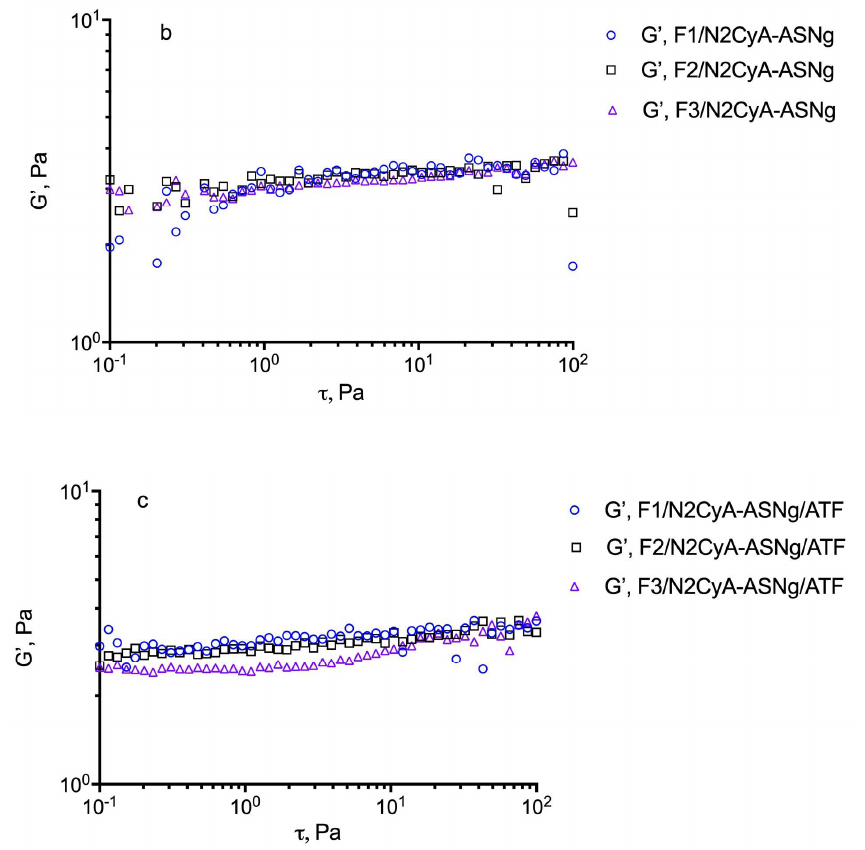
Figure 4. Determination of the linear viscoelastic range (DLVR). Elastic modulus (G’) at 5 Hz plotted versus shear stress (t) for: ( a ) GG-LA dispersions (Fx), ( b ) GG-LA dispersions containing nanomicelles (Fx/N2CyA-ASNg) and ( c ) GG-LA dispersions containing nanomicelles mixed with artificial tear fluid (ATF) in 30:7 ratio, (Fx/N2CyA-ASNg/ATF).